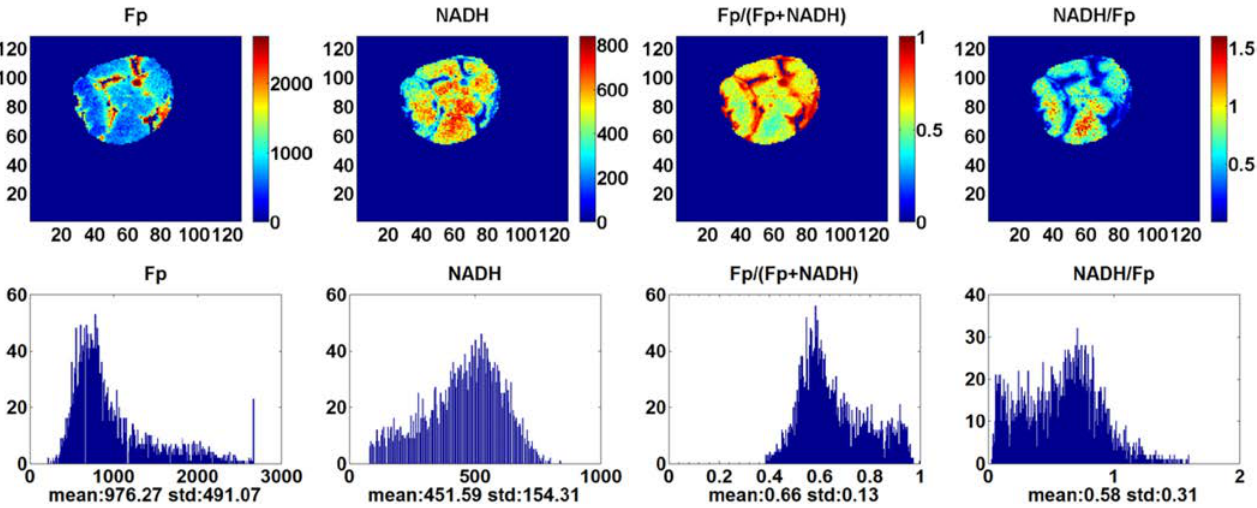
Fig. 2. Typical pseudo-color redox images (top row) and their corresponding histograms of a tumor in the control group (3500 (cid:1) m under the skin). Image resolution: 200 (cid:1)